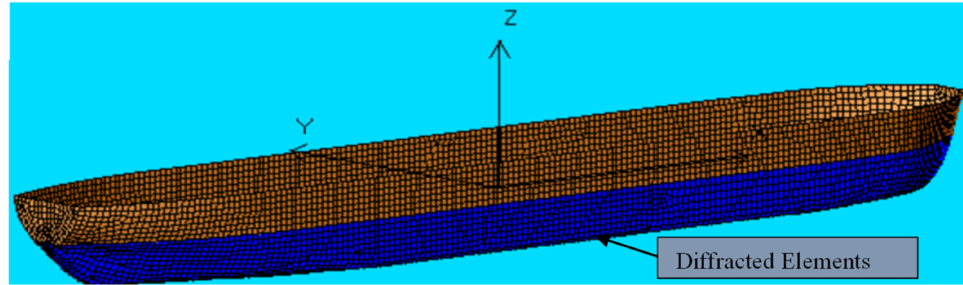
Figure 2. Generated mesh of numerical